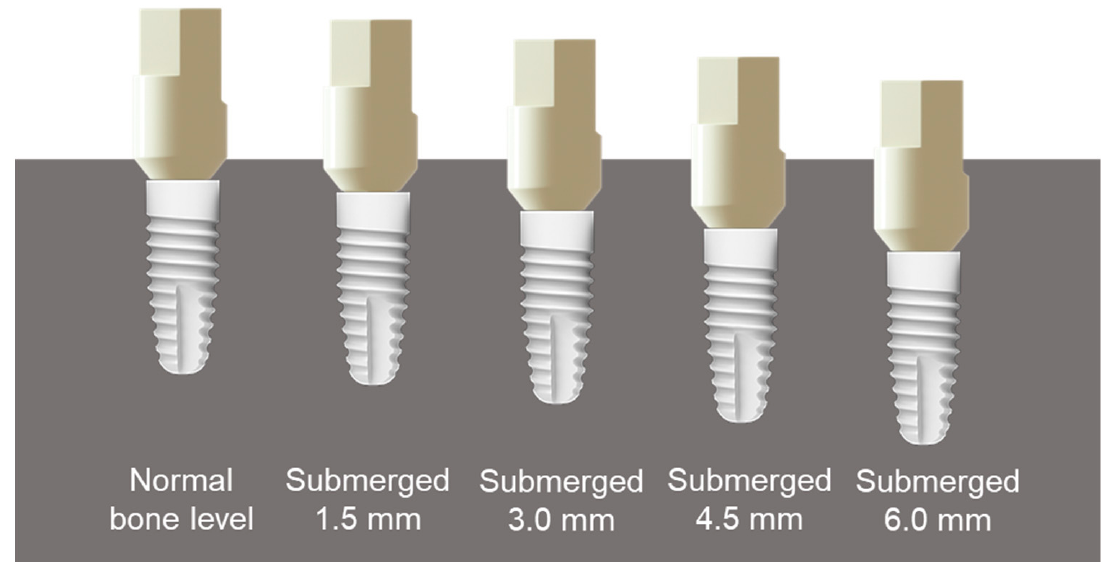
Figure 3. An ISB (implant scan body) was connected to each master model and scanned. The exposed length of the ISB varied with the implant level.